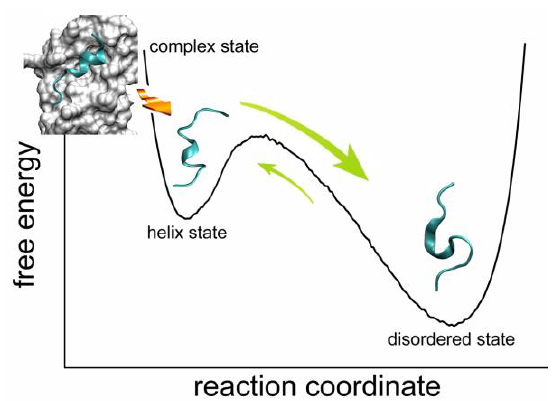
Figure S3. Schematic free energy landscape of p53N. The orange arrow indicates the relaxation of the initial complex structure to the helix state. The two green arrows indicate the transitions between the helix state and the disordered